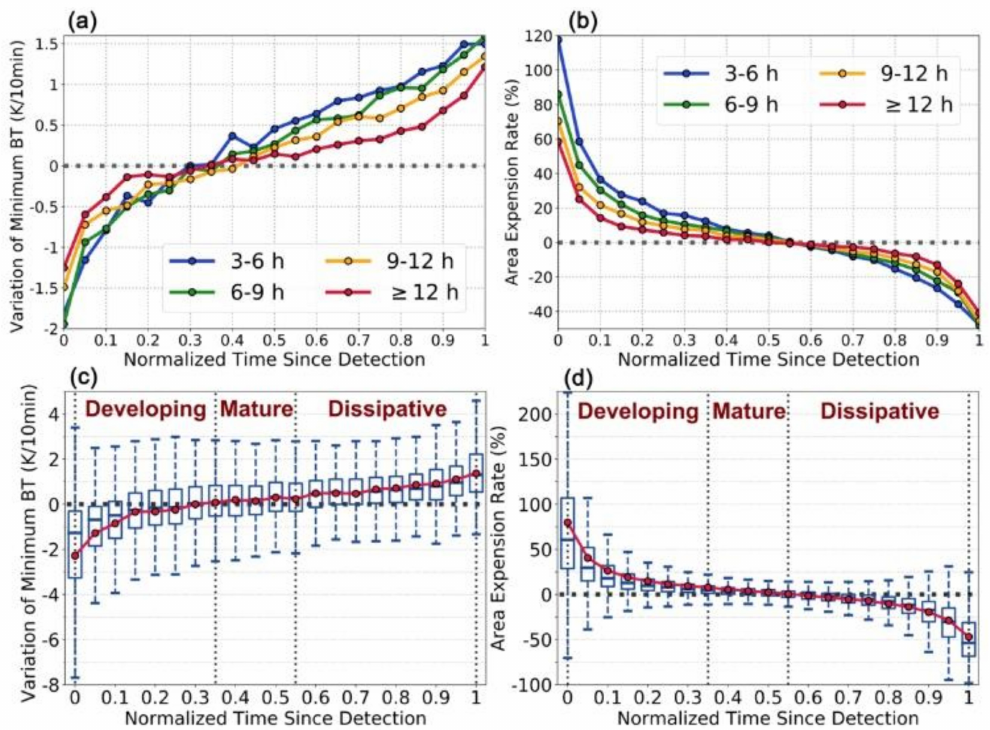
Figure 7. Temporal evolution of ( a ) the variation in minimum BT for 10-min intervals, and ( b ) area expansion rate for the MCSs with di ff erent lifetimes (in color) as a function of normalized time since detection. The boxplots denote ( c ) the changing rate of minimum BT and ( d ) area expansion rate of MCSs during their lifetimes, including developing, mature, and dissipative stages. The upper and lower whiskers in each column denote the 95th and the 5th percentile of the changing rate. The upper and lower edges of each box represent the changing rate at 75th and 25th percentile, the solid lines in the middle indicate the medians, and the red dots represent the mean